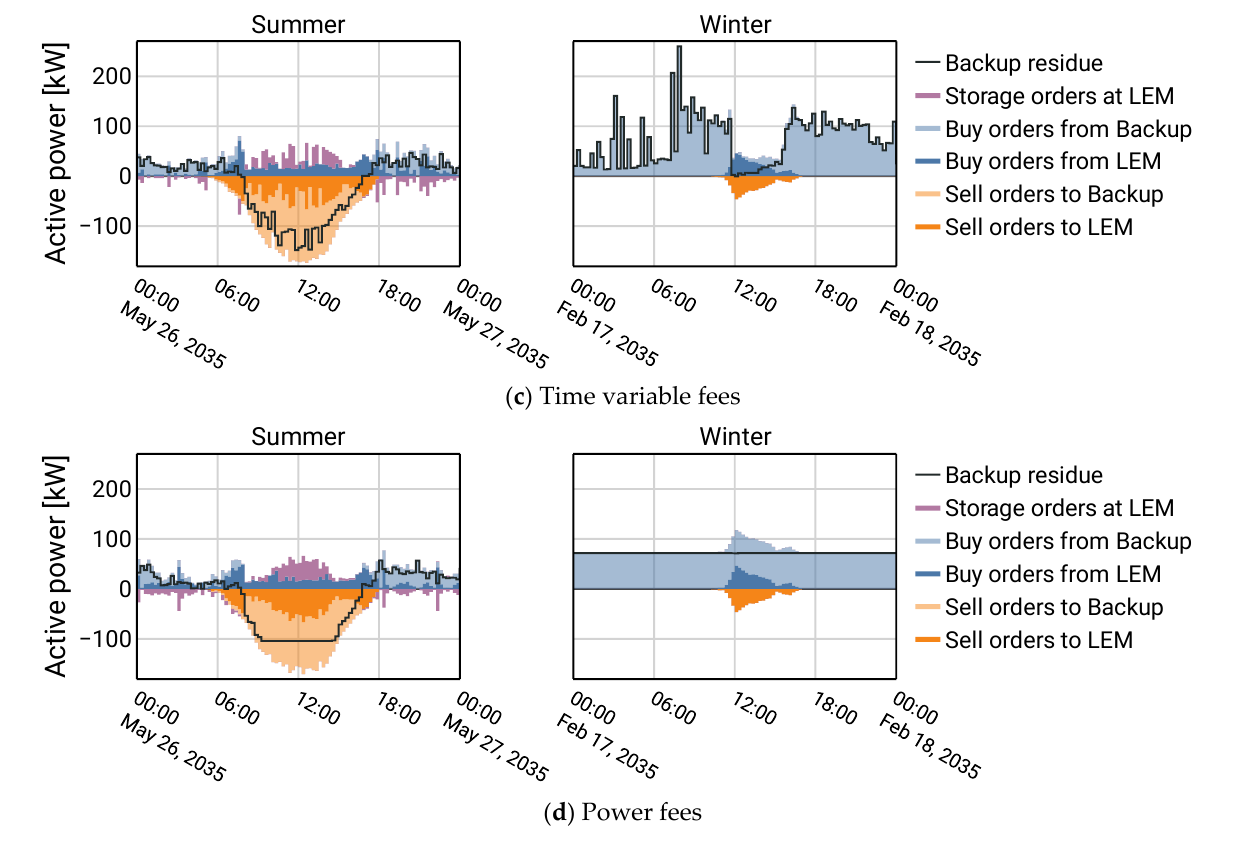
Figure 4. Market matching results of sample summer and winter days for a variation of grid tariff scenarios, the scenario year 2035 and the rural distribution grid.